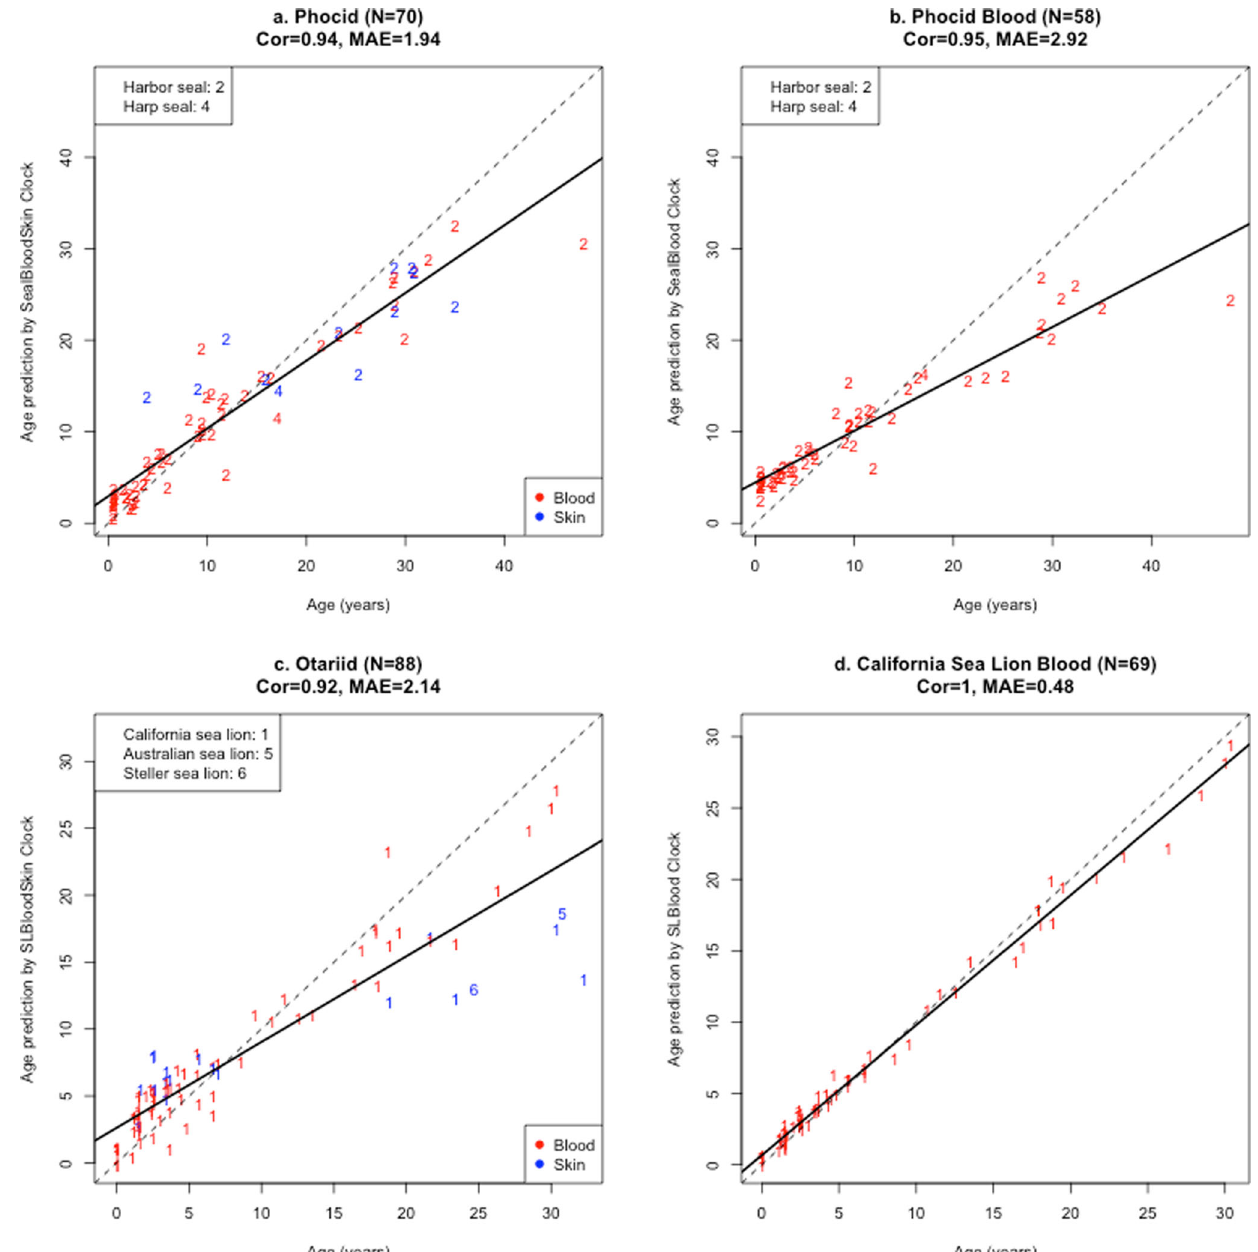
Fig. 2 Cross-validation study of the epigenetic clock for seals (Phocidae) and sea lions (Otariidae). a – d report Leave-One-Out-Cross-Validation (LOOCV) regression estimates of the Phocid blood + skin clock ( a ), the Phocid blood clock ( b ), Otariid blood + skin clock ( c ) and California Sea Lion Blood clock ( d ). This cross-validation method was used to estimate the clocks overall performance at predicting age from novel samples (skin or blood) collected from the species used in clock development. Species are presented with different integer numbers and identi fi ed in the legend; tissue types are indicated by two colors (red = blood, blue = skin). Each panel depicts a linear regression line (black dashed line), a diagonal reference line ( y = x ), the sample size ( N ), Pearson correlation (Cor) across all samples, and the median absolute error (MAE) across samples from all